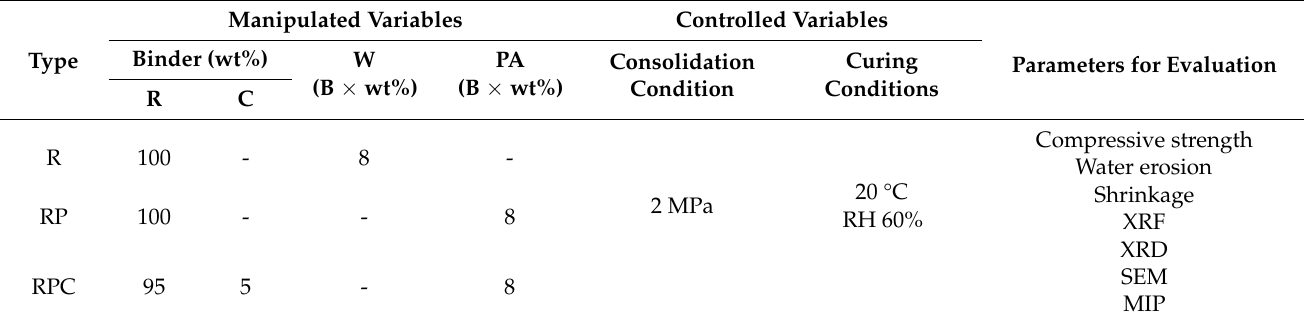
Table 2. Experimental